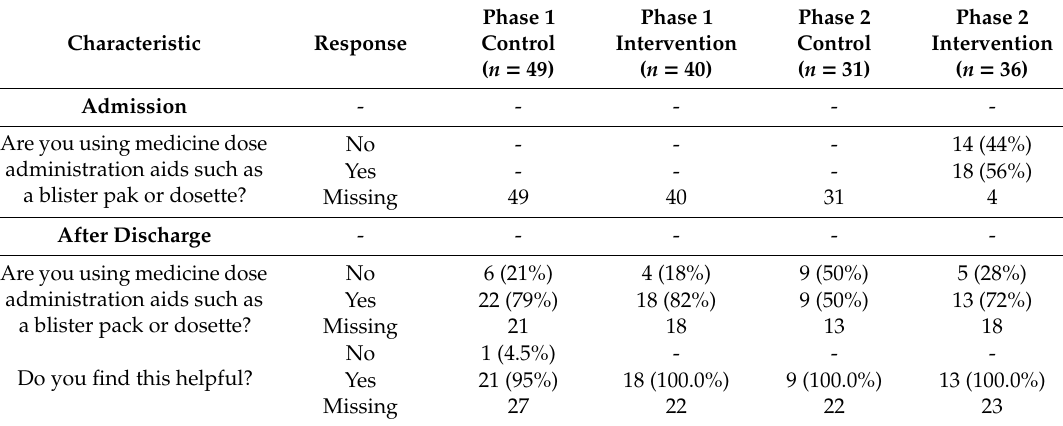
Table 2. Dose administration aids